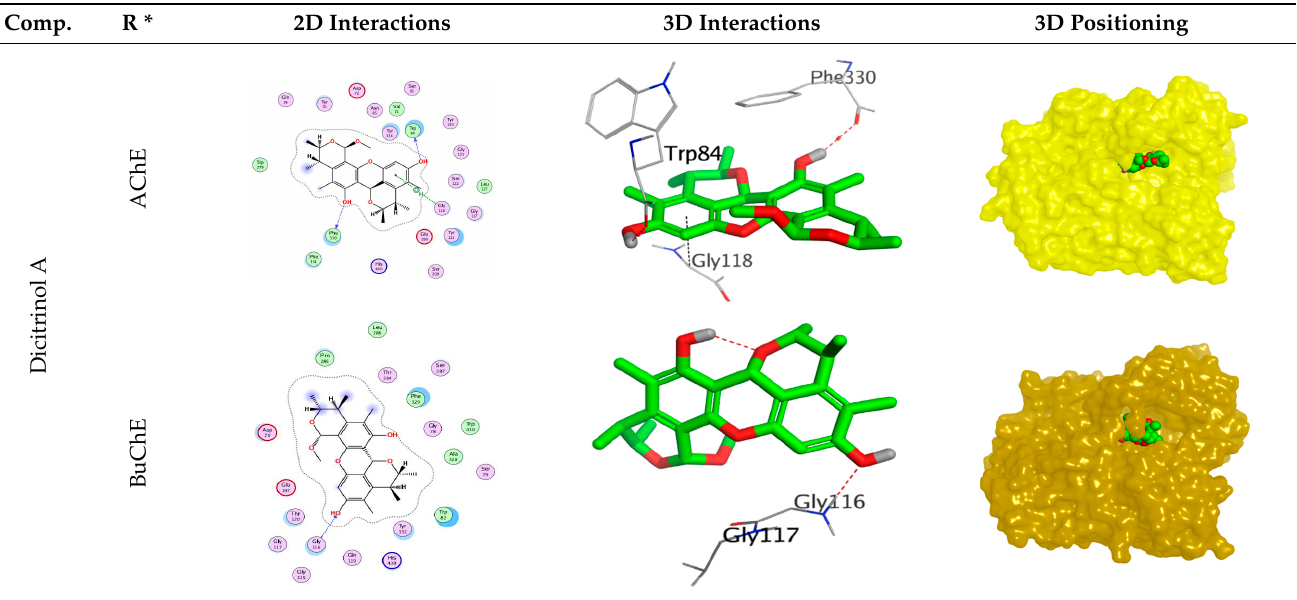
Table 4. The 2D, 3D interactions and receptor pocket positioning for the most promising candidates within the binding sites of both AChE and BuChE